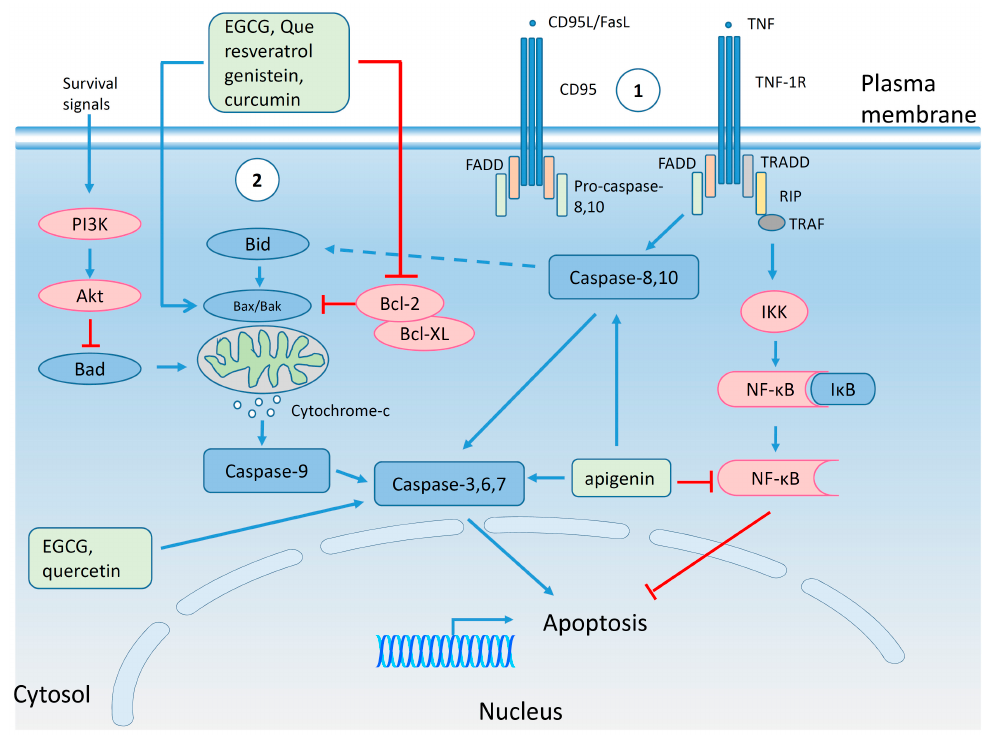
Figure 4. The effect of polyphenols on apoptotic signaling pathways. Extrinsic (1) and intrinsic (2)